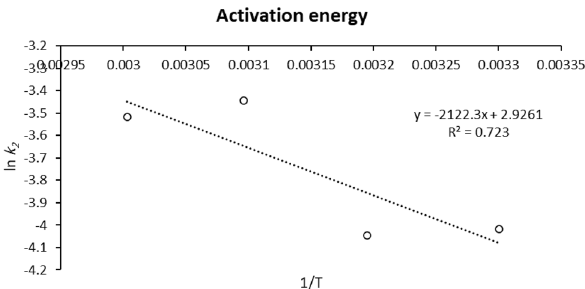
Fig. 9 The plot of rate constant (ln k 2 ) vs temperature (1/T) to deter- mine the activation energy (Δ E a ) of the